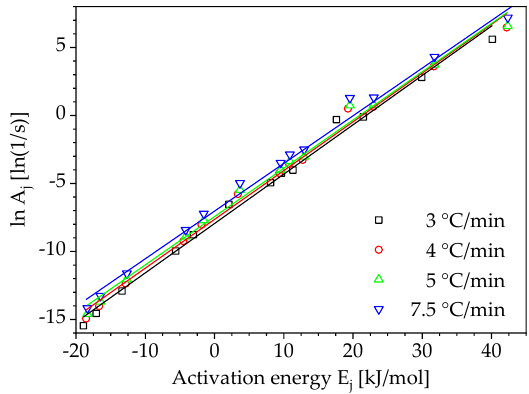
Figure 8. Compensation lines for different heating rates ( calculated ln 𝐴 𝛼 − 𝐸 𝛼 pair, — linear fit).